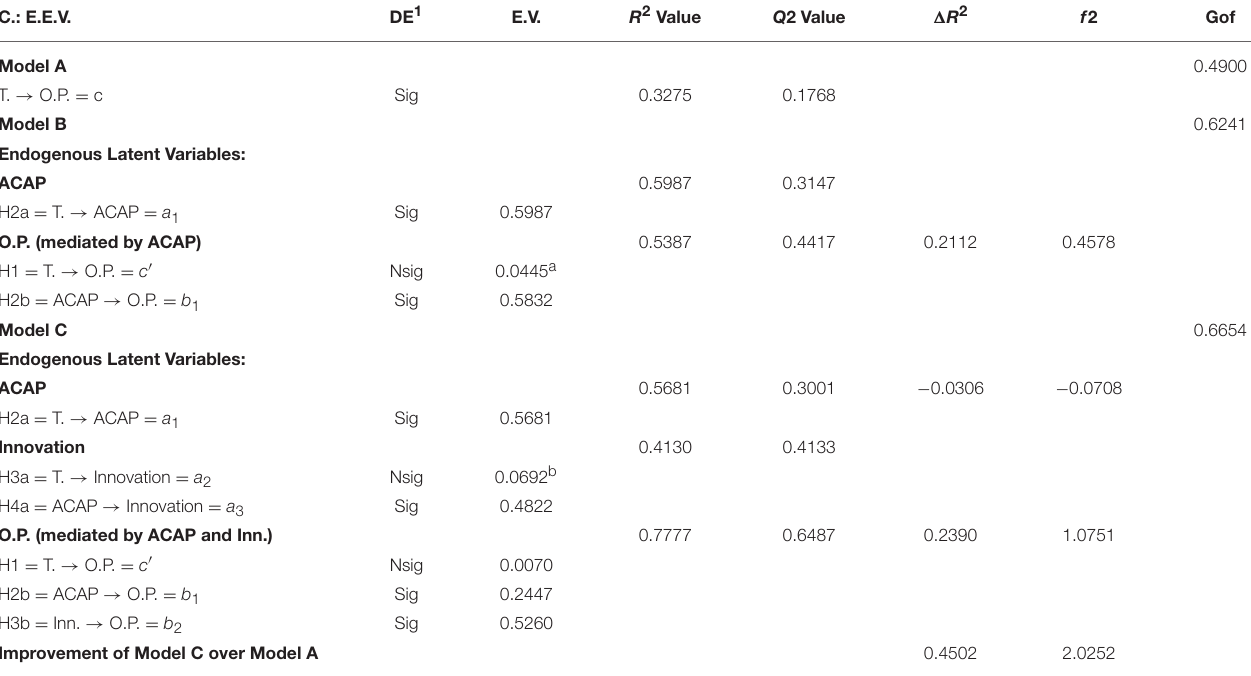
TABLE 6 | Summary of evaluation of the structural models: consistency, accuracy, predictive relevance, effect sizes and global fit. C.: E.E.V.